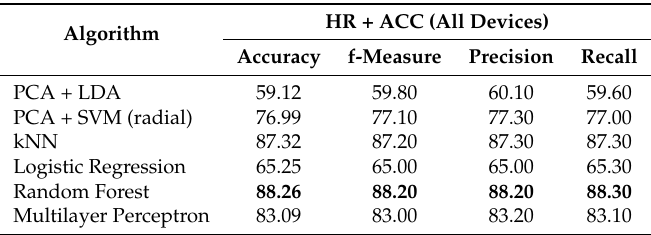
Table 6. Stress with context classification accuracy, f-Measure, precision and recall values with different ML algorithms: three-class. HR +ACC for all devices.